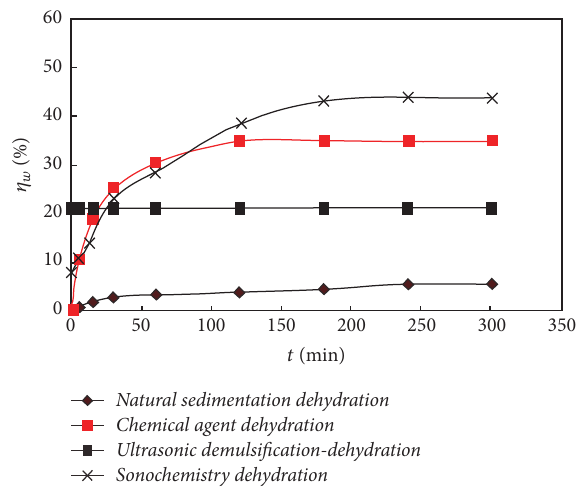
Figure 7: The comparison of demulsifying and dehydrating crude oil using ultrasonic excitation, natural sedimentation, demulsifier chemical, and sonochemistry method, respectively, at 70 ∘